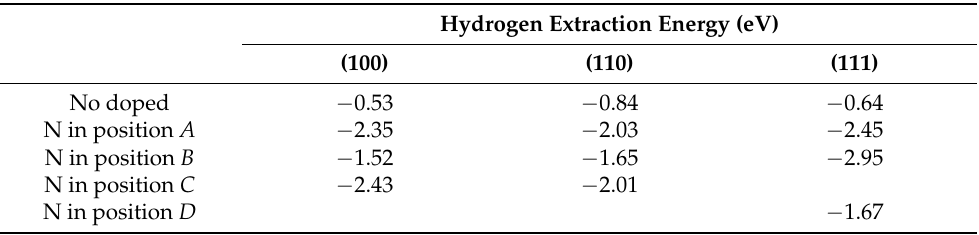
Table 1. Hydrogen extraction energy E H ex for the diamond (100), (110), and (111) surfaces with or without nitrogen doping at positions A , B , C , and D